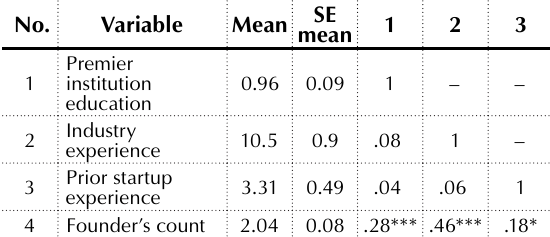
Table 2. Descriptive statistics and Pearson